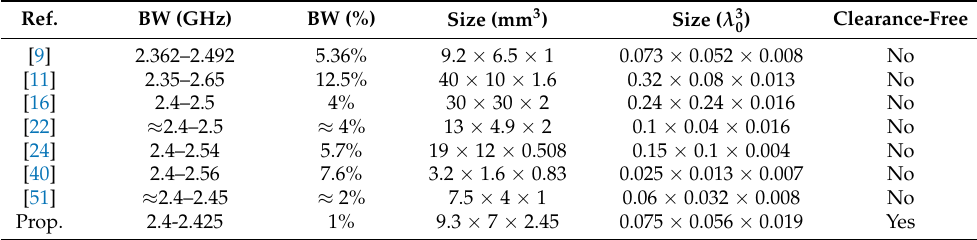
Table 1. Comparison Table.